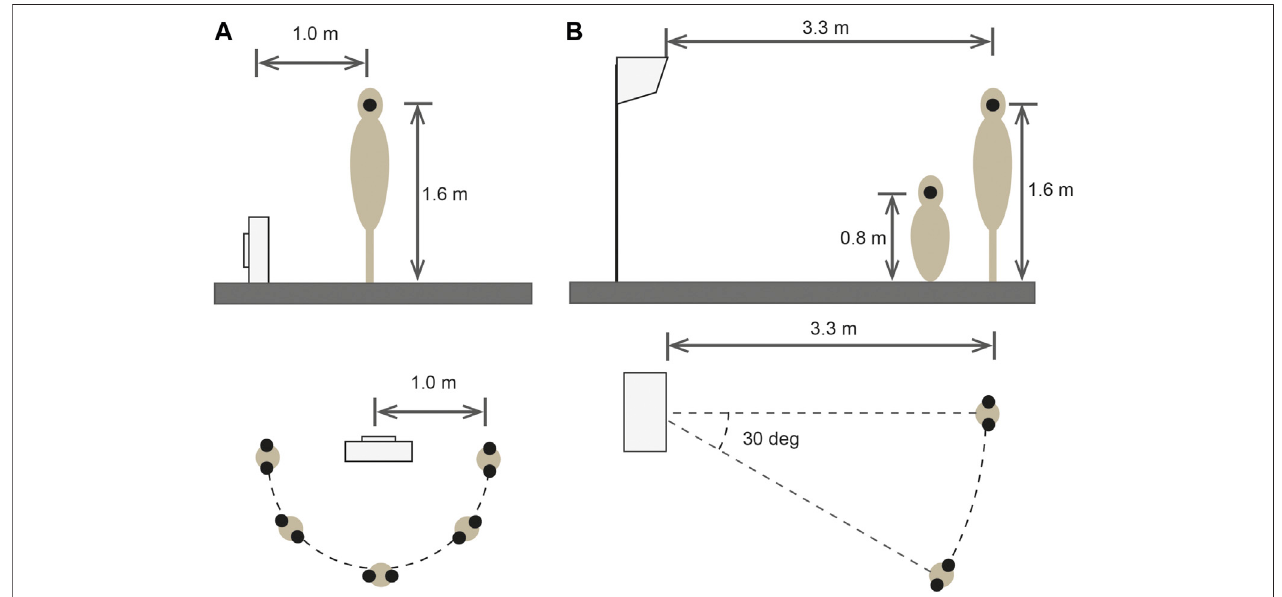
FIGURE 1 | Installation of (A) outlet and (B) inlet air conditioner units in an anechoic room. The binaural microphone was placed at the ear position on the mannequin.